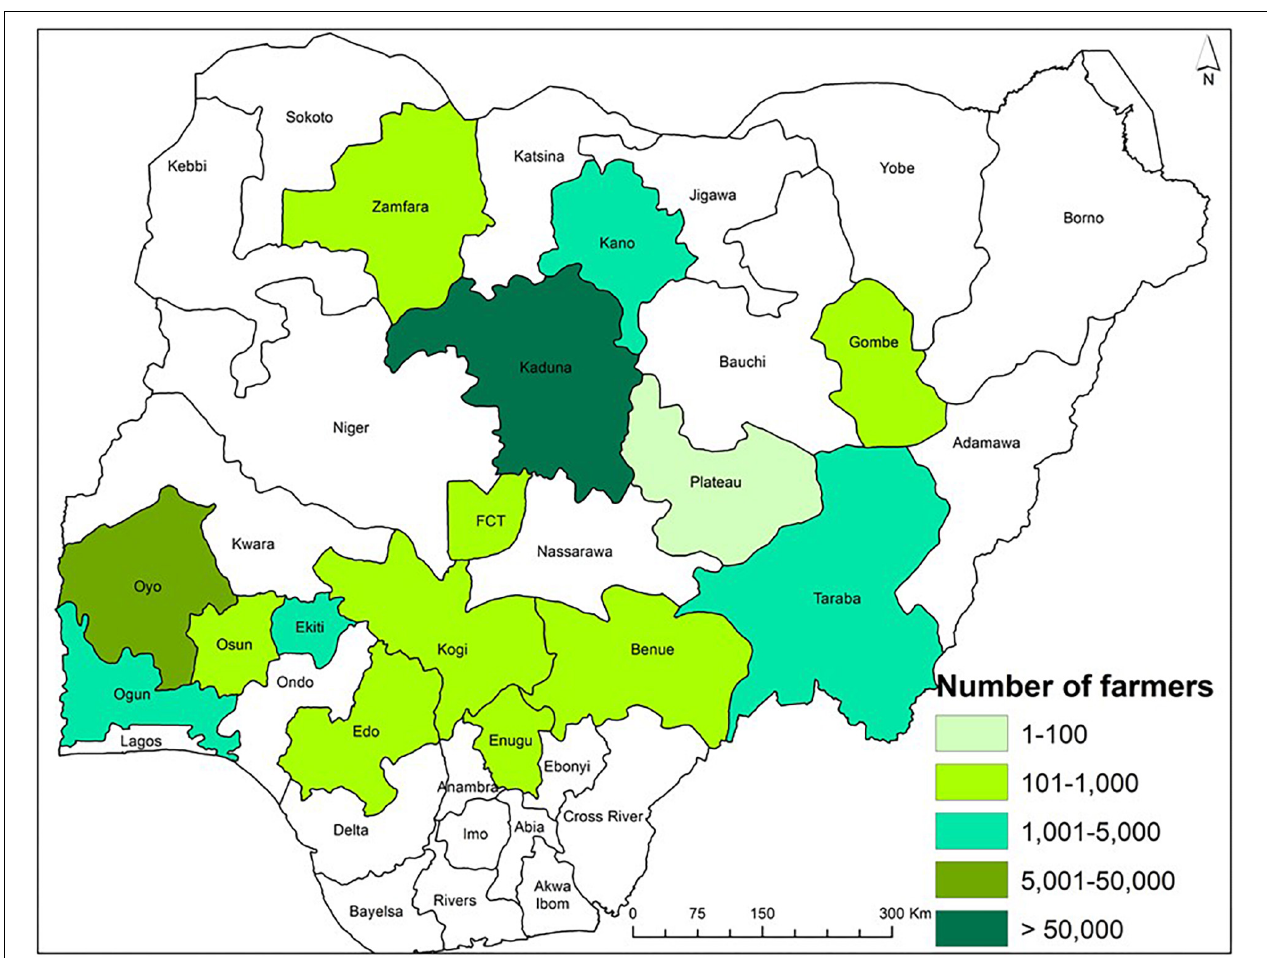
FIGURE 2 | Map of Nigeria showing the number of farmers that participated in the AgResults Project and applied an atoxigenic biocontrol product in maize in various states during 2013 to 2018.